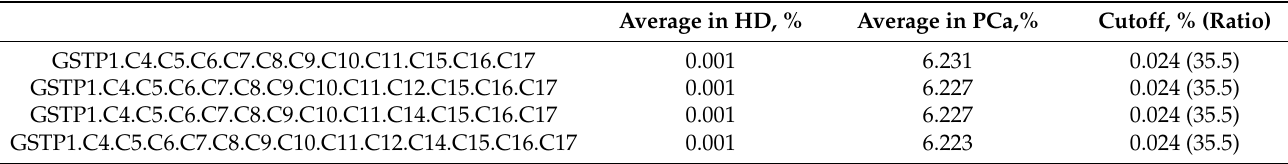
Table 7. The best combinations of cytosines for TaqMan PCR